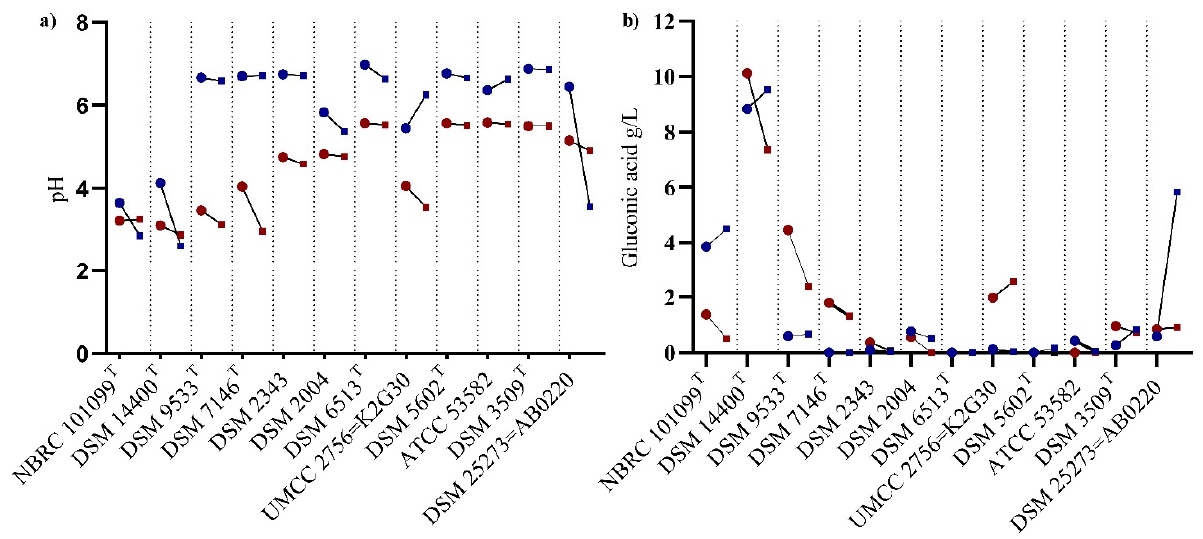
Figure 2. ( a ) pH variation at 70 g/L and 250 g/L sucrose concentrations, at 48 and 96 h of incubation (vs) ( b ) Production of gluconic acid under similar conditions. — 48 h of incubation; — 96 h of incubation; — color refers to 250 g/L sucrose); — color refers to70 g/L sucrose.